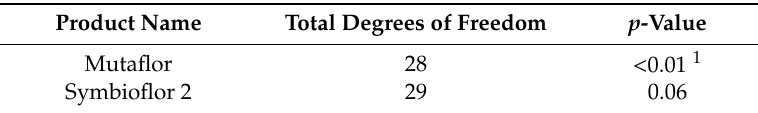
Figure 1. Comparison of log 10 -transformed arithmetic mean E. coli counts to manufacturer claims under Conditions 1 and 2; error bars denote a 95% confidence interval (CI). Table 2. Results of ANOVA between the enumeration of lot numbers of Mutaflor and Symbioflor 2 under test Condition